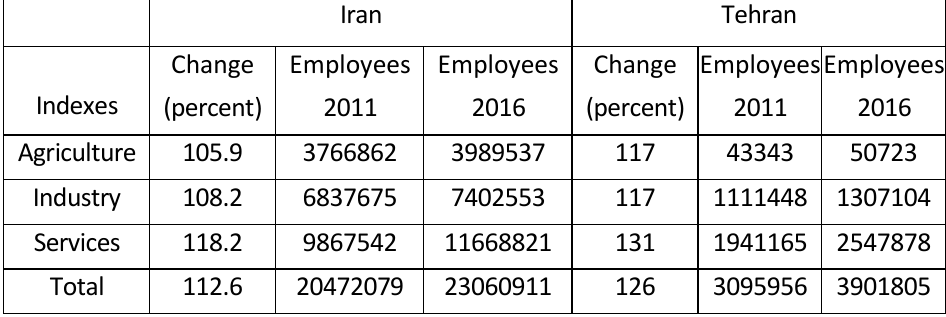
Table 6: The changes in the economic sectors of Tehran in the Izard model